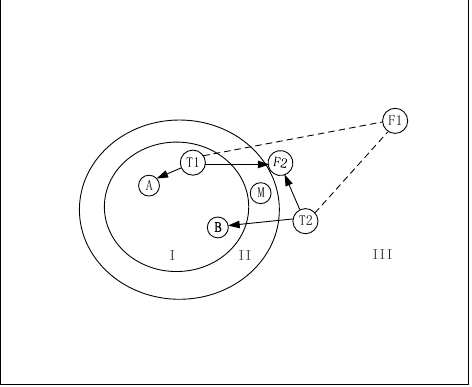
Figure 3. The schematic diagram of critical faulty data construction.